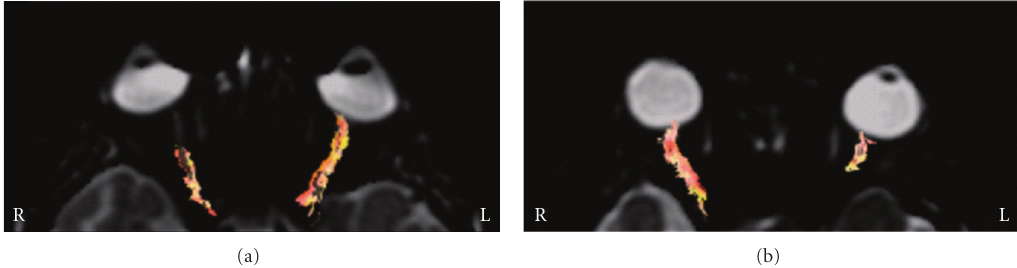
Figure 7: Optic nerve DTI in patients with acute right (a) and left (b) optic neuritis. DTI was able to show optic fibres in the una ff ected optic nerve. At the site of the optic nerve lesion fibres cannot be reconstructed due to FA alterations; in some cases this helped define more precisely the site of the optic nerve lesion responsible for the visual impairment. L and R: left and